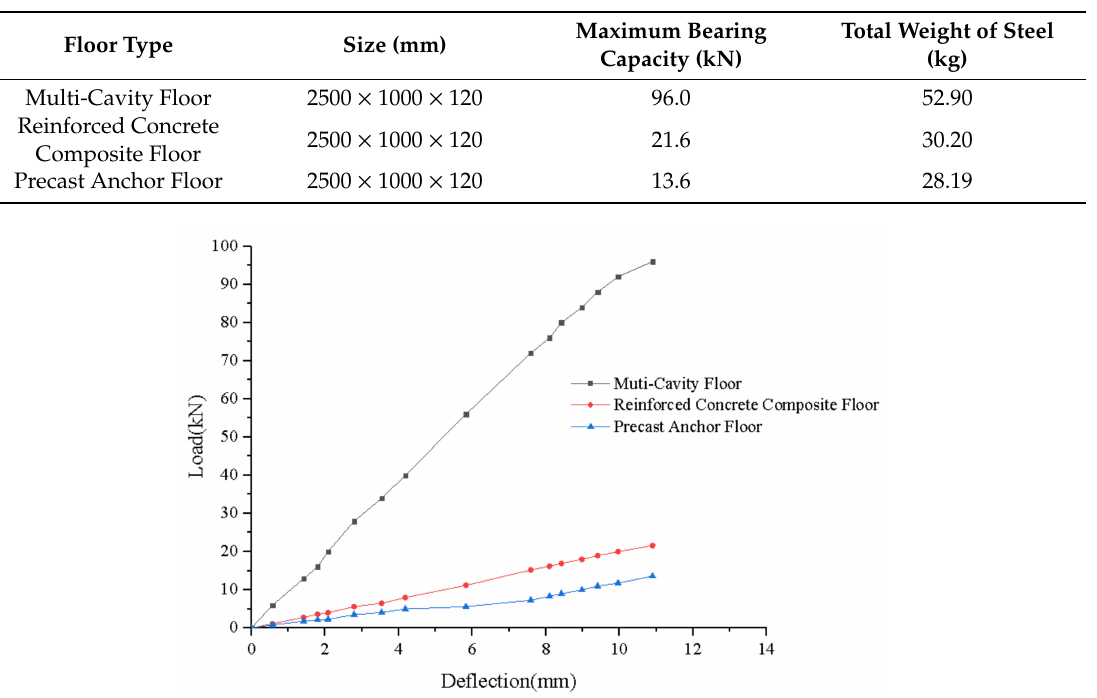
Figure 11. Load-deflection curve of three precast